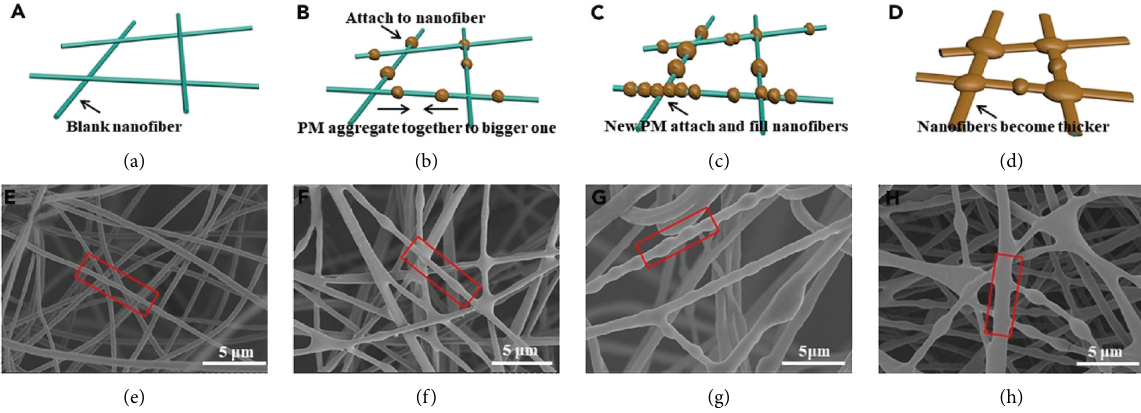
Figure 7: Interaction of PM with nanofibers (adapted with permission from ref. [45]).